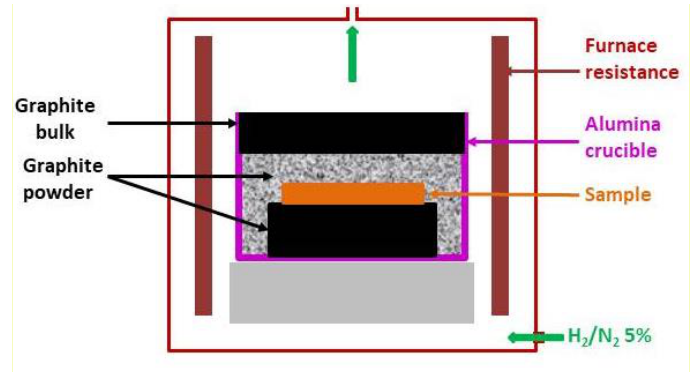
Figure 4. Set-up of sintering.